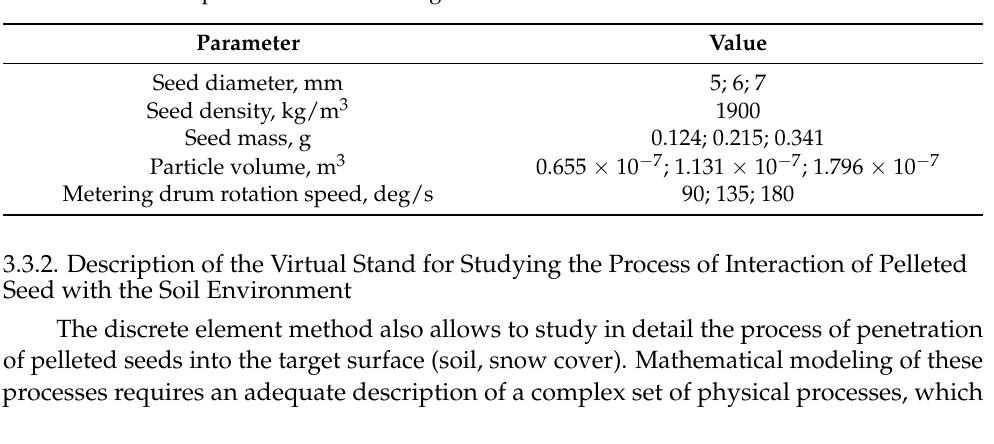
Table 5. Simulation parameters seed sowing device.